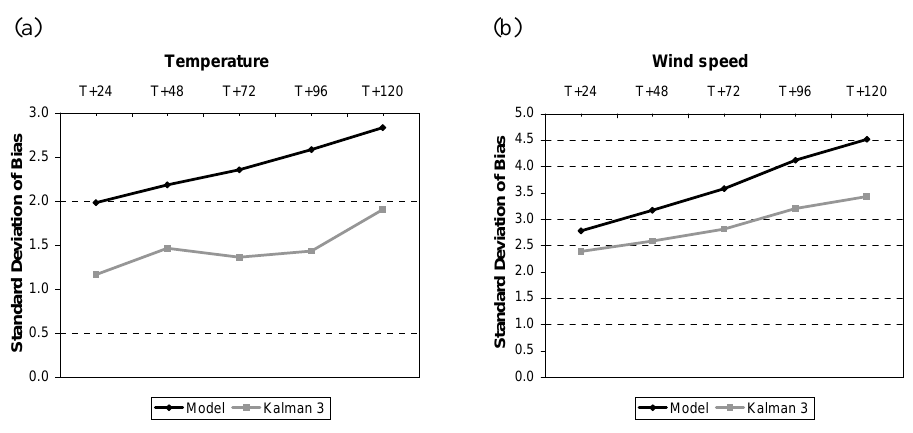
Fig. 8. Variation of (a) temperature and (b) wind speed Absolute Bias with forecast time for the direct model output and after the application of order-3 Kalman filter, for the year 2003.